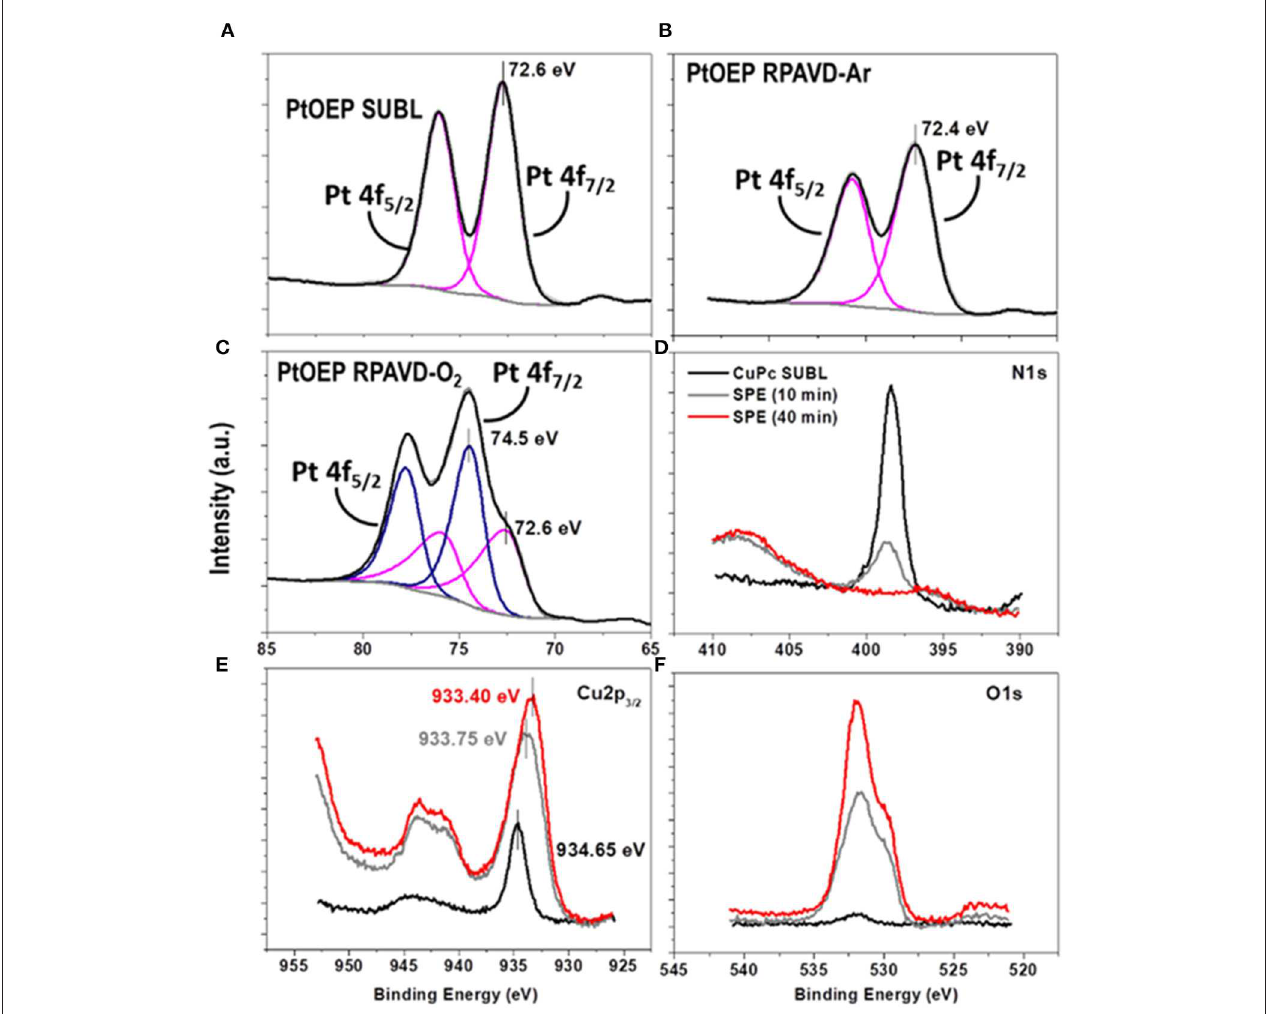
FIGURE 3 | Pt 4f peaks obtained by XPS of the PtOEP samples deposited under direct sublimation (A) , RPAVD-Ar (B) and RPAVD-O2 (C) . Evolution of the N 1 s (D) , Cu 2p (E) and O 1s (F) peaks of the CuPc-SUBL sample after soft-plasma etching treatments of different